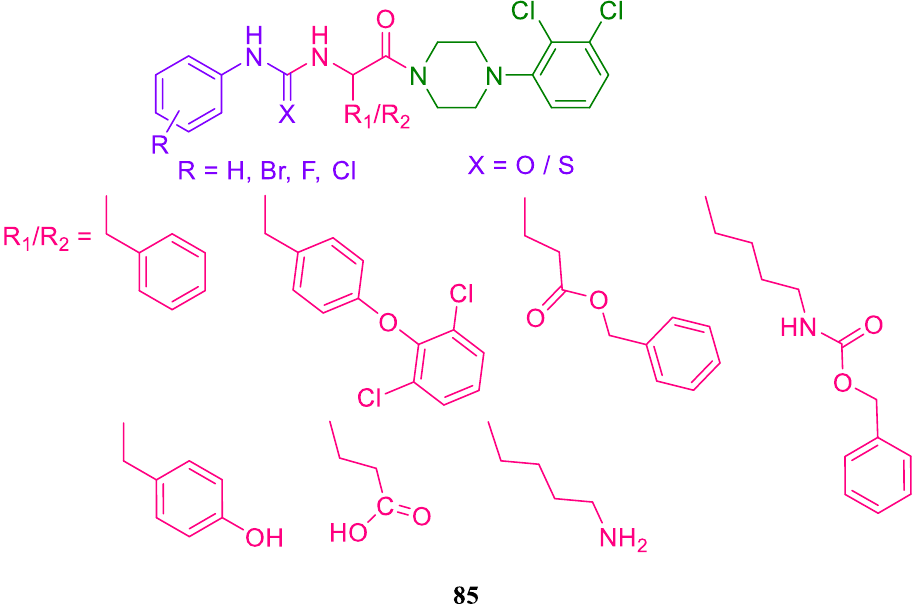
Figure 69. Amino acids conjugated to 2,3-dichlorophenyl piperazine. Latypova D R et al. synthesised a novel series of N-substituted α -amino acids ana- logues consisting hexahydropyrimidine moiety ( 86 ) and tested their cytotoxicity (Figure 70). The authors examined the cytotoxicity of the compounds in cancer cells. One-pot synthesis of Mannich reaction of 3-oxobutanamide or ethyl acetoacetate with HCHO and amino acid hydrochlorides in acetate buffer rendered diastereomerically pure N-substituted hexahydropyrimidine-amino acids in 71 to 89% yield. The target compound was gener- ated as four stereoisomers based on the information from NMR spectra and chiral HPLC evaluation. These included three diastereomers, two of which were in the meso form. At the same time, one pure ( S , S )-enantiomer of the relevant compound was obtained from ( S )-Ala under the identical conditions. The cytotoxic activity was examined in human cells (HEK293) and cancer cells (SH-SY5Y and Jurkat). It was observed that analogues of hexahydropyrimidine showed moderate inhibitory activity with IC 50 ranging from 37 to 88 µ M against all the tested cell lines. From the activity profile, it was noticed that compounds with EDGs, such as -CH 3 , showed higher cytotoxicity than the aromatic and EWGs. It is important to notice that among the diastereomers, (-)-isomer exhibited weak toxicity against Jurkat SH-SY5Y, and more prominently against HEK 293 cells [158].